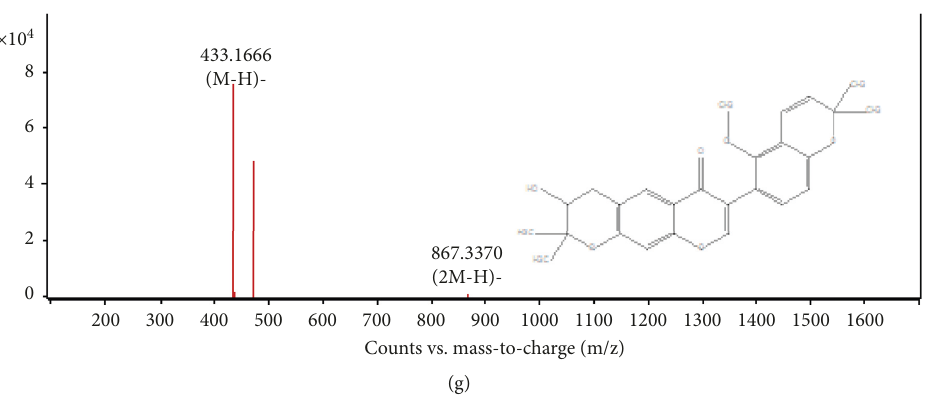
Figure 4: Molecular ion from LC-MS chromatogram screening of the C. latifolia root extract. (a) hydroquinone, (b) phloridzin, (c) dimethyl caffeic acid, (d) pomiferin, (e) scandenin, (f) monobenzone, and (g)